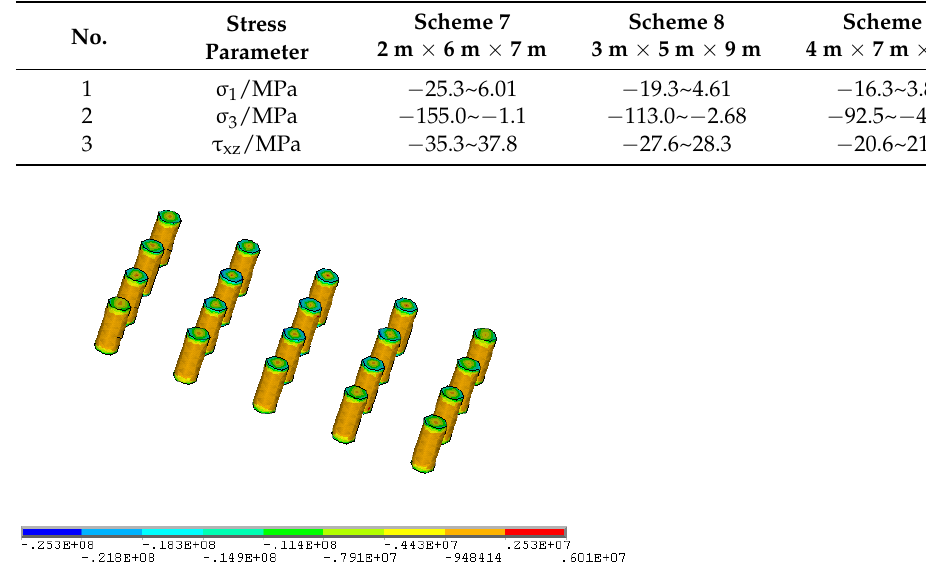
Figure 31. Maximum principal stress distribution of scheme 7 pillars at 1480 mL (parameters of